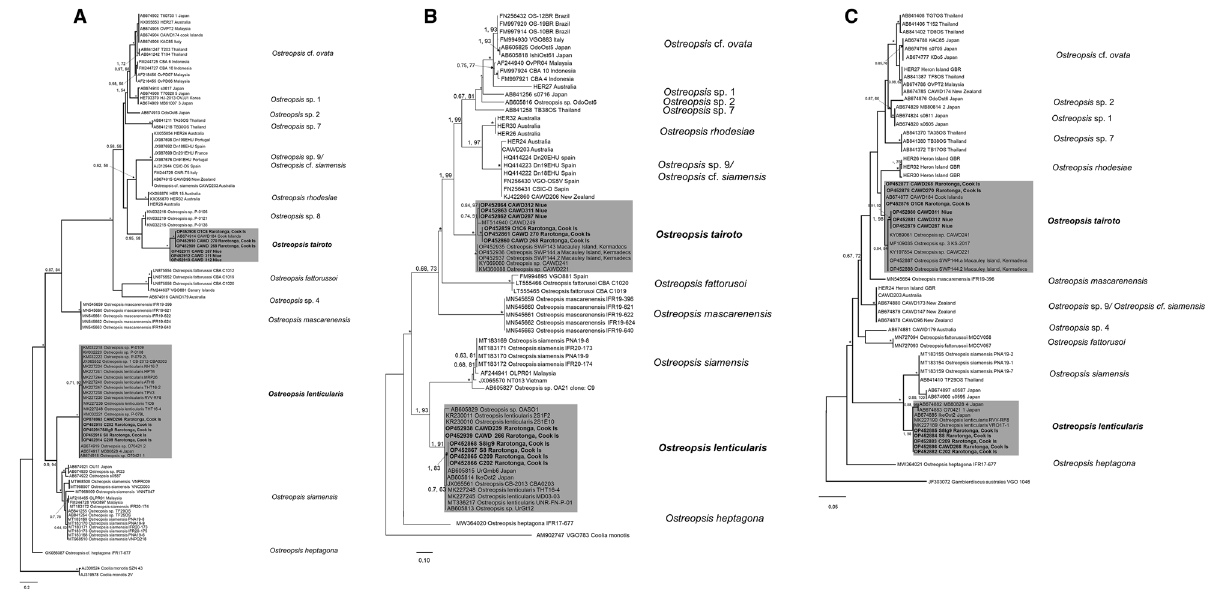
Figure 14. Maximum Likelihood (ML) phylogenetic tree of various Ostreopsis strains using primer sets for ( A ) ITS/5.8S rDNA, ( B ) D1-D3 LSU rDNA and ( C ) D8-D10 LSU rDNA. Numbers at nodes represent posterior probabilities from Bayesian Inferences (BI) and bootstrap support values from Maximum Likelihood (ML) based on 1000 pseudo-replicates. *represents 1, 100 support values for BI and ML respectively. Strains isolated is this study are indicated in bold and a grey